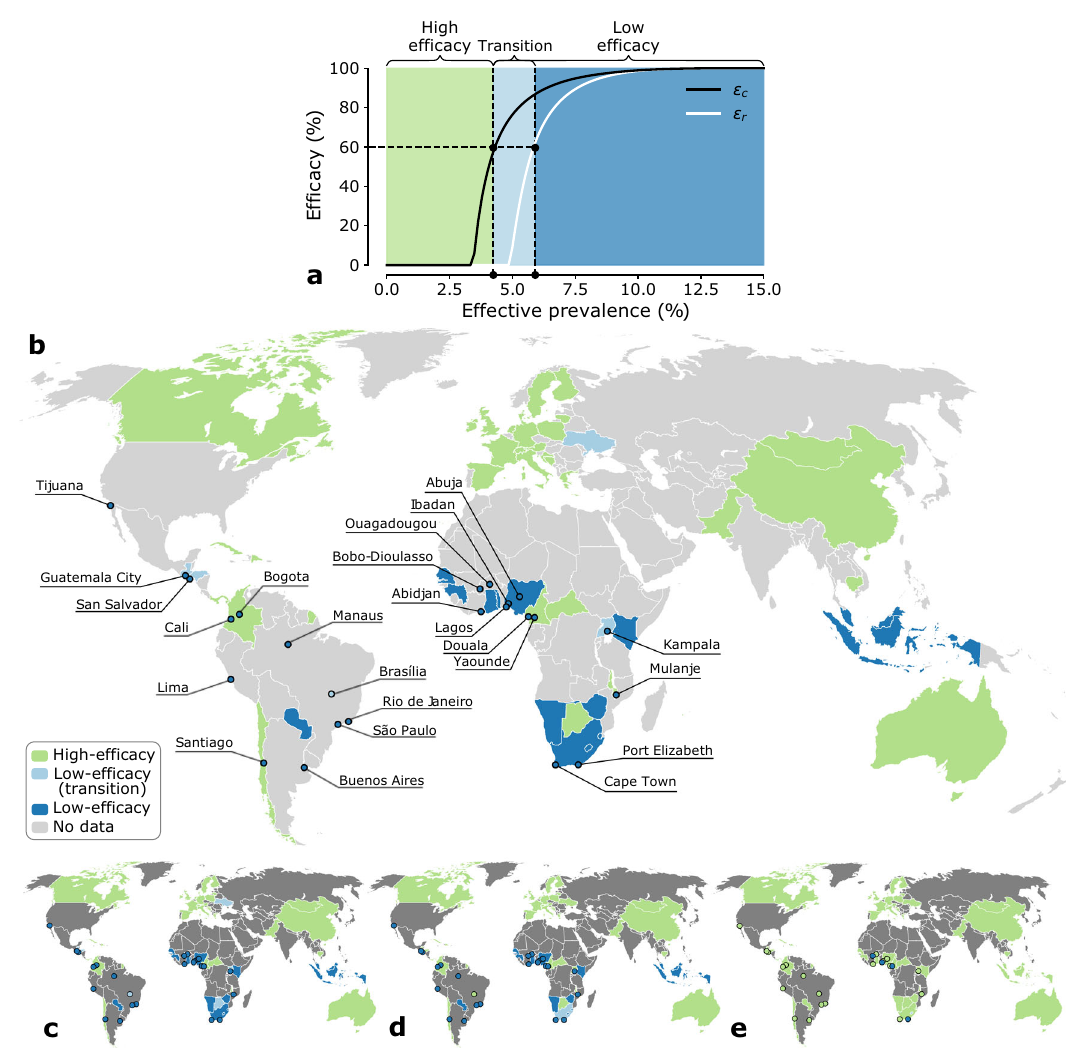
Fig. 3 PrEP distribution in communities of men-having-sex-with-men (MSM) in 58 countries. a Phase diagram of PrEP in MSM communities. The x-axis shows the effective prevalence, i.e., the fraction of individuals who are living with HIV and can potentially transmit it. It is estimated from data on HIV prevalence, treatment coverage, viral suppression rate (see Supplementary Note 6 and Supplementary Note 7). The y-axis shows ef fi cacy of PrEP. The horizontal dashed line is 60% ef fi cacy. The solid black curve is critical ef fi cacy ϵ c , the solid white curve is ϵ r . The range of effective prevalence in the high- ef fi cacy region at 60% ef fi cacy is colored in green. The range of effective prevalence in the low-ef fi cacy region at 60% ef fi cacy is colored in dark blue, and light blue (transition zone). b Map showing parameter region estimates in 58 countries, 24 cities (see Supplementary Note 6 for data sources and estimates of effective prevalence). Communities in the high-ef fi cacy region are green, communities in the low-ef fi cacy region are in dark blue, light blue (transition zone). c The same as b , assuming ef fi cacy at 44% (IprEx trial). d The same as b , assuming ef fi cacy at 86% (IPERGAY study). e The same as b , in the scenario that each community reaches UNAIDS's 95 – 95 – 95 targets for testing, treatment, and viral